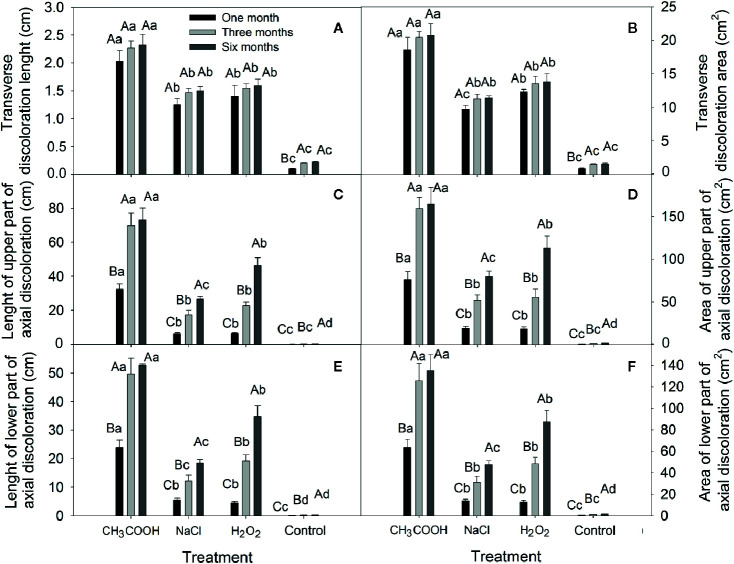
Changes in the transverse and axial discoloration induced by different chemicals. (A, C, E) indicate discoloration length of the transverse, axial-upper, and axial-lower, respectively. (B, D, F) indicate discoloration area of the transverse, axial-upper, and axial-lower, respectively. Similar uppercase letters indicate that the temporal effect is not significantly different. Similar lowercase letters indicate that the treatment effect is not significantly different (p > 0.05). Bar represents standard deviation.